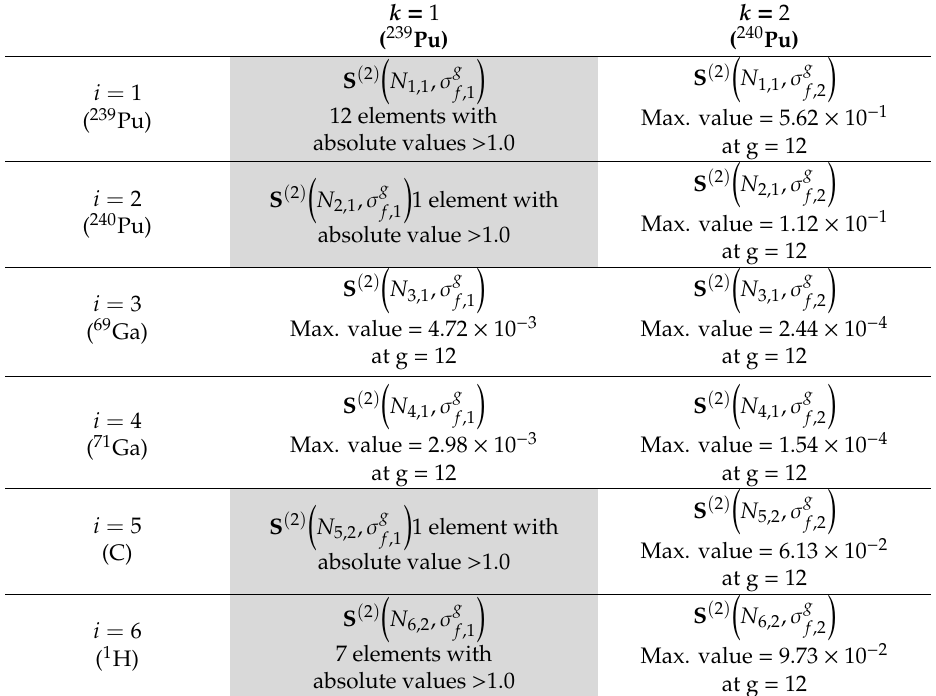
(cid:18) (cid:19) N i , m , σ g , i = 1, ... ,6; k , m = 1,2; g = 1, ... f , k